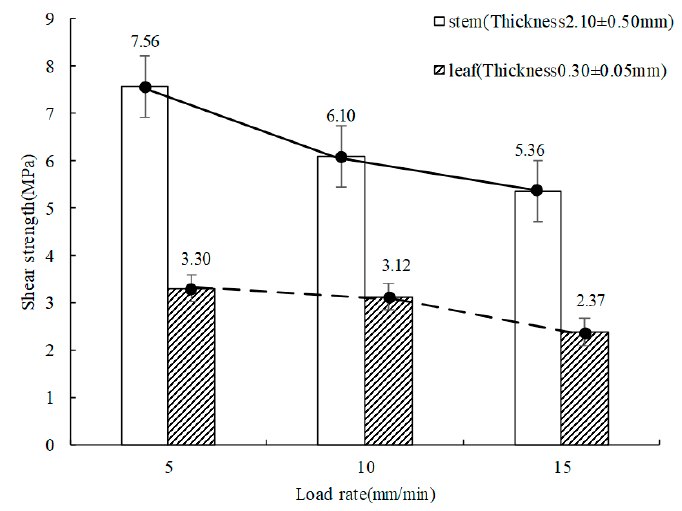
Figure 19. Shear strength of wakame under different loading rates.